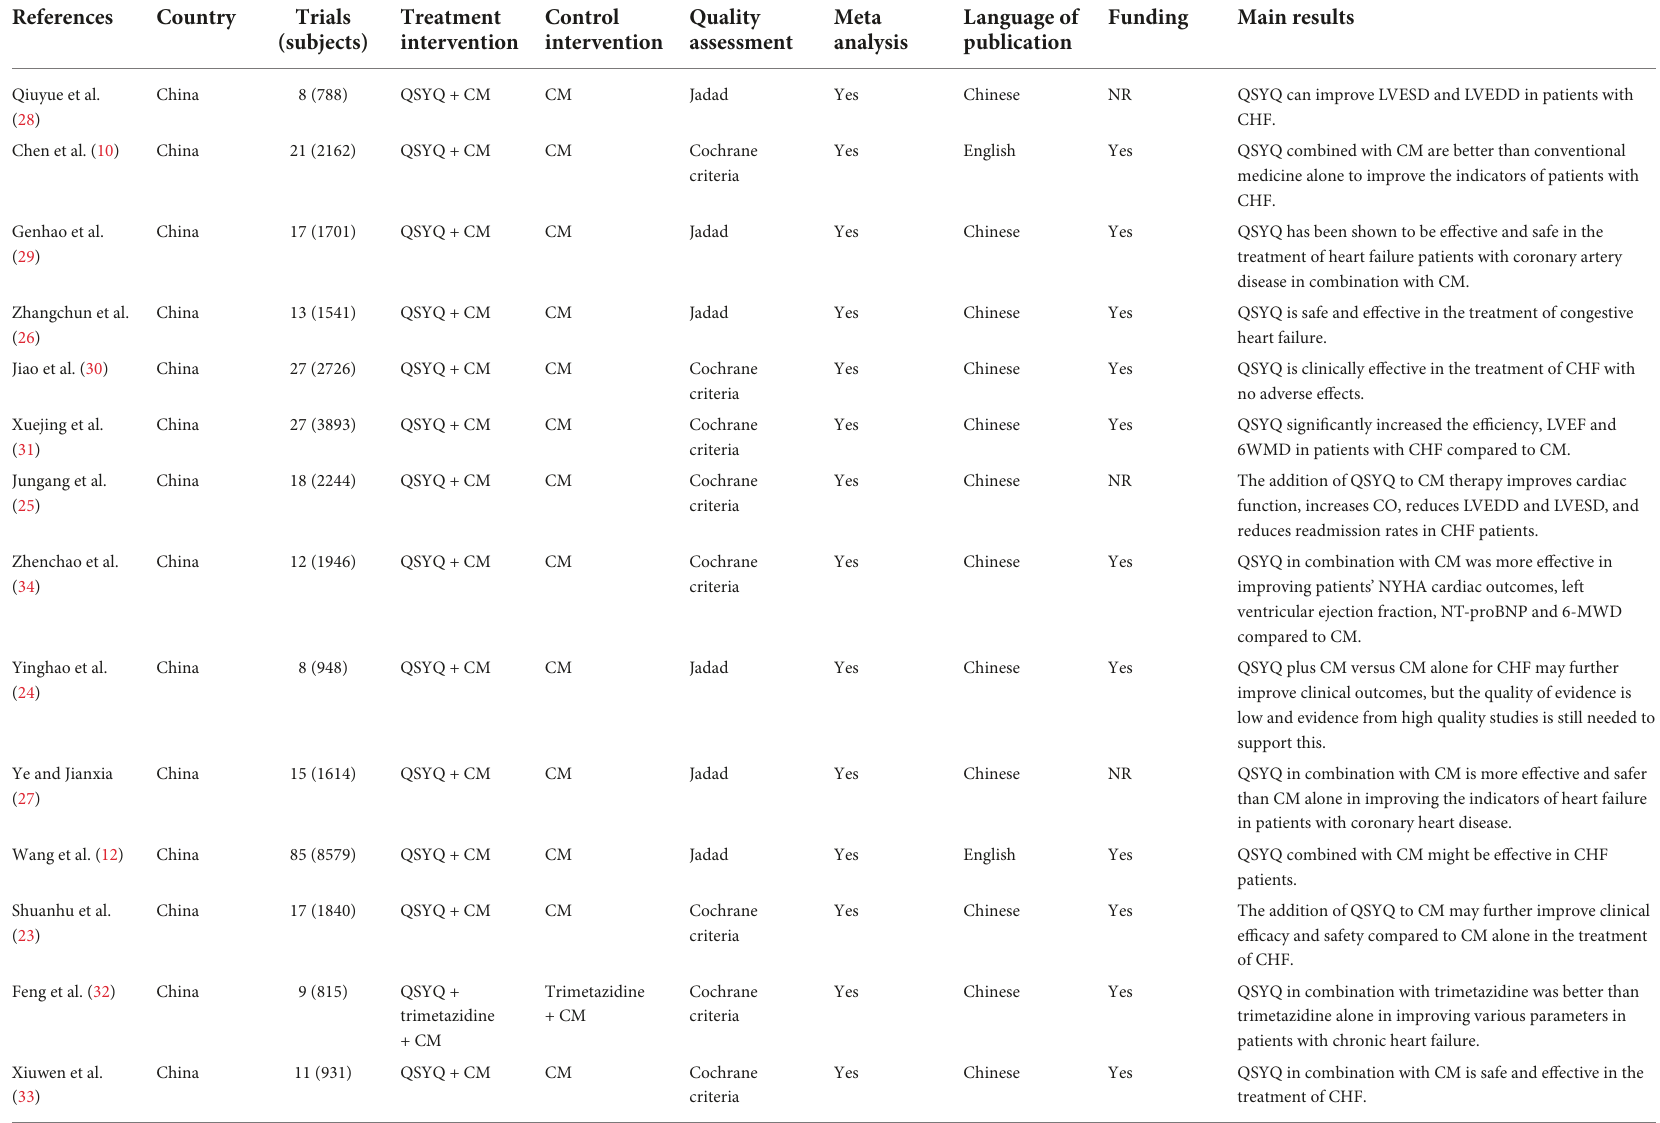
TABLE 2 Main characteristics of included